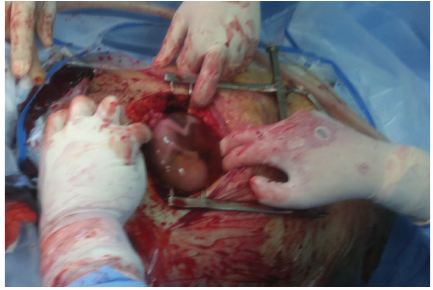
Figure 1: Partial rupture of the right lateral uterine.